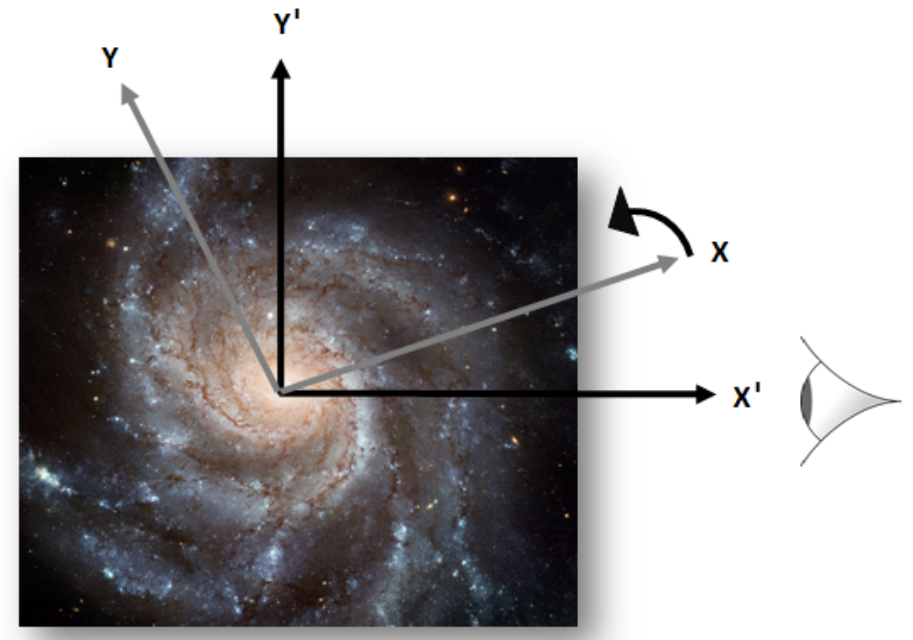
Figure 2. The measured velocities presented in RCs are valid only with respect to K (cid:48) , by definition. If K (cid:48) is not inertial, then the relative motion between K (the inertial frame) and K (cid:48) (the observational frame) includes only rotation. For the sake of simplicity, in this figure the observer is located on the galactic plane. The definitions of K and K (cid:48) , however, hold for any